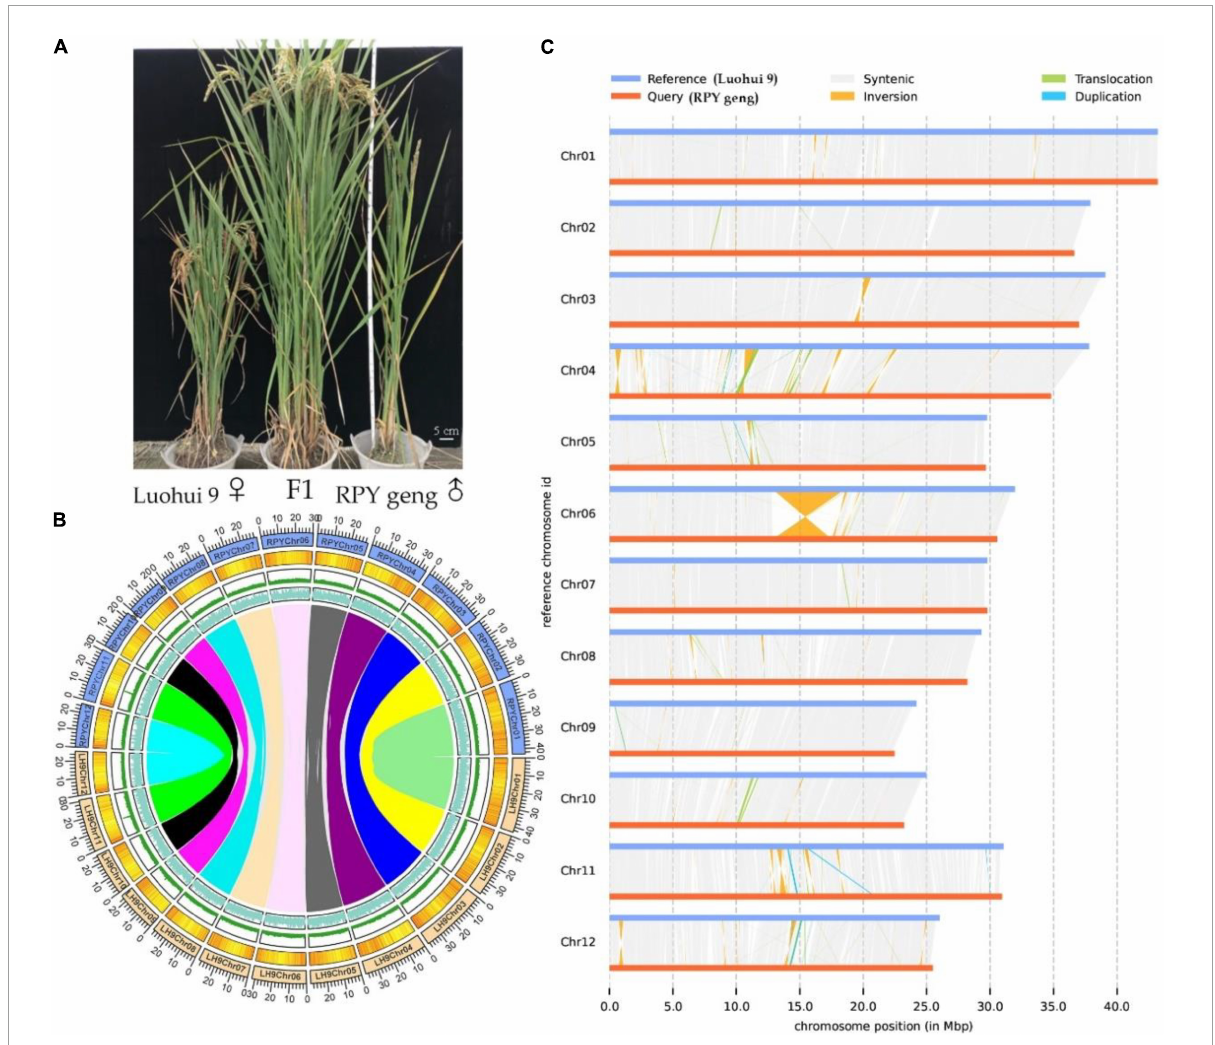
FIGURE1 Whole plant phenotype (A) , genomic characteristics (B) , and large structural variations (C) between RPY geng and Luohui 9. The tracks from outside to inside are the chromosome, gene density, repeat sequence density, and GC content and the different color links represent orthologous gene pairs among chromosomes in (B)